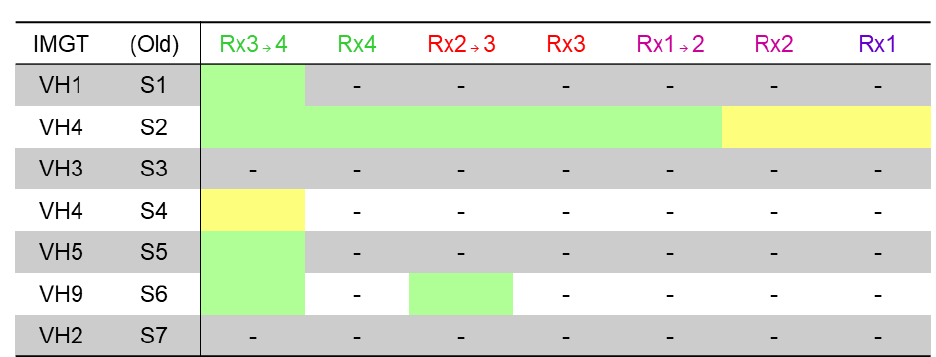
6 of 15 served as templates for 48 nested PCR reactions per replicate, amplifying a slightly smaller fragment in each instance (Figure 1B,C). The results for these PCRs are summarised into seven IgH V -gene groups (Figure 1C). Only reactions with primers specific for IMGT ® subgroup IgHV4 (defined previously as subgroup IgHV2 [14,15]) repeatedly amplified equine H V -gene fragments in both first and second rounds of a nested PCR, with increased efficiency for smaller gene products (1500 bp, 1270 bp, 730 bp, and 460 bp). IMGT ® defined subgroups IgHV1, IgHV4, IgHV5, and IgHV9 (defined previously as subgroups IgHV1, IgHV2 and IgHV4, IgHV5, and IgHV6, respectively [14,15]) also gave nested PCR products, but in only one or two reactions, using reverse primer Eq- IgHJx(SalI)R after Eq-IgG1CH1/x-R. A multiplexed nested PCR using all EQ-HV screening primers (Table 1) together with Eq-IgG1CH1/x-R and then Eq-IgHJx(SalI)R also yielded a strong IgHV gene product, likely driven by IMGT ® subgroup IgHV4. For the light chain p roducts, only Igλ gene primers alone or in multiplexed pools reproducibly amplified strong PCR products, while Igκ primers yielded no product. The entire Igλ gene ORF was recovered. Together with previous studies highlighting IgH V -gene and lambda- gene usage bias [9,10,12,13], these data confirm that most equine polyclonal antibodies derive from the IMGT ® IgHV4 gene cluster (formerly IgHV2), paired with a lambda gene.